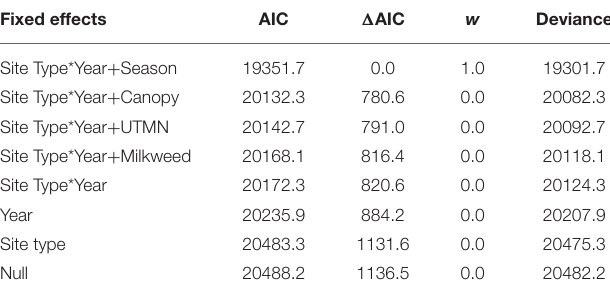
FIGURE 2 | Estimated density per 50-m 2 (95% CI) of monarchs on both random and non-random transects surveyed in Iowa,